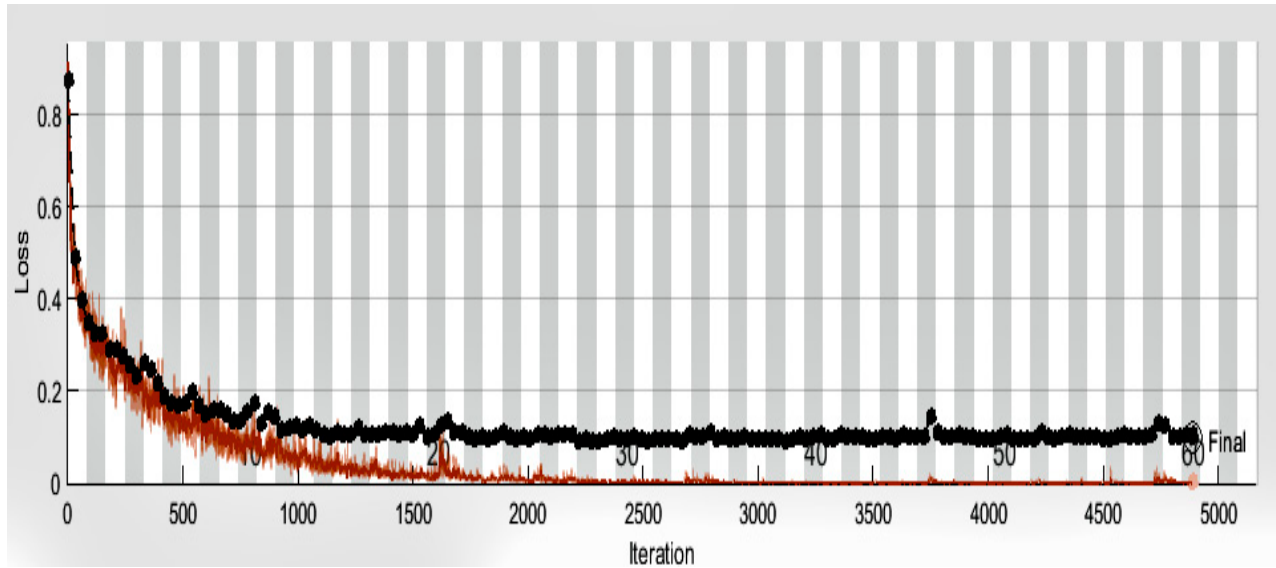
Figure 5. Training and validation loss of proposed CovidDetNet framework (black line shows testing loss whereas red line shows training loss).